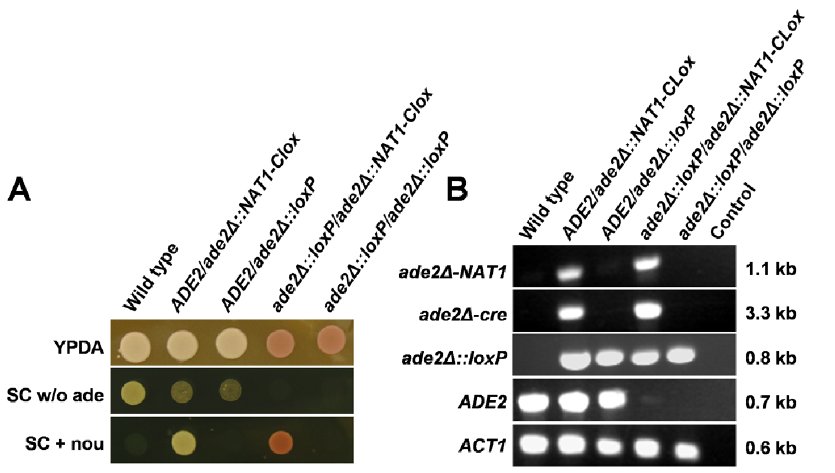
Figure 5. Validation of NAT1-Clox for single marker recycling in a prototrophic clinical isolate. NAT1-Clox was used to generate a homozygous ade2 D /ade2 D mutation in C. albicans SC5134. (A) Confirmation of the expected phenotypes for wild type ( ADE2/ADE2 ), unresolved heterozygous ( ADE2/ade2 D ::NAT1-Clox ), resolved heterozygous ( ADE2/ade2 D ::loxP ), unresolved homozygous ( ade2 D ::loxP/ade2 D ::NAT1-Clox ) and resolved homozygous mutants ( ade2 D ::loxP/ade2 D ::loxP ). Growth media are specified on the right: w/o, without a specific supplement; nou, nourseothricin. (B) PCR confirmation of the genotypes for these mutants using primers specific for each allele (specified on the left). PCR product lengths are specified on the right. ACT1 was used as a positive control, and a no-DNA control was included